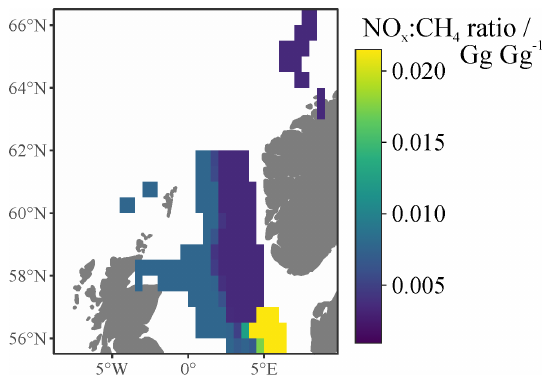
Figure 9. ECLIPSE v5 flaring NO x : CH 4 ratios in the North